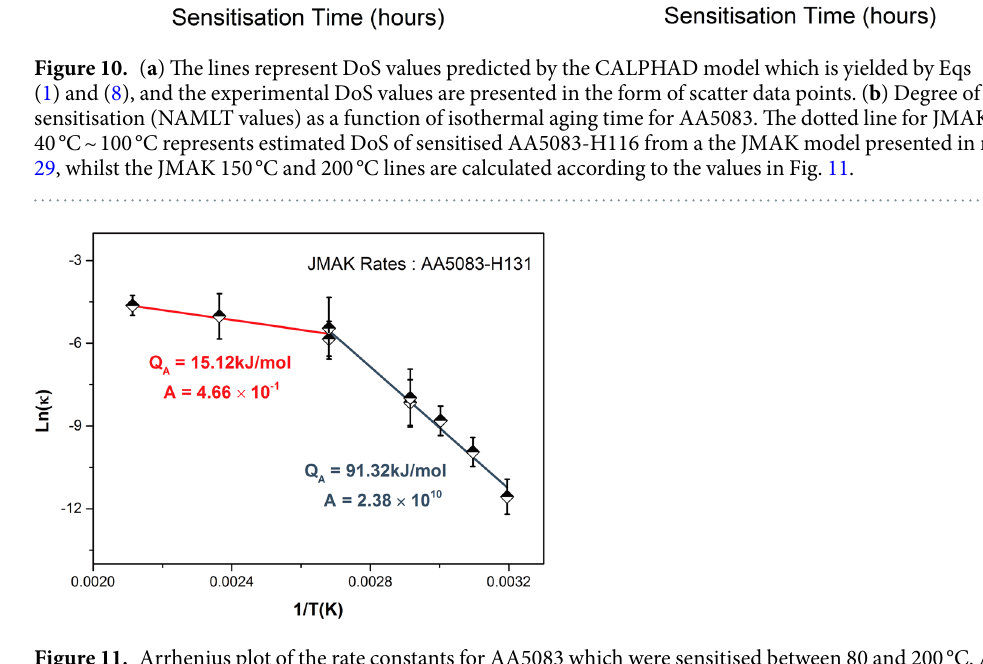
Figure 11. Arrhenius plot of the rate constants for AA5083 which were sensitised between 80 and 200 °C. A change in the kinetics of sensitisation was